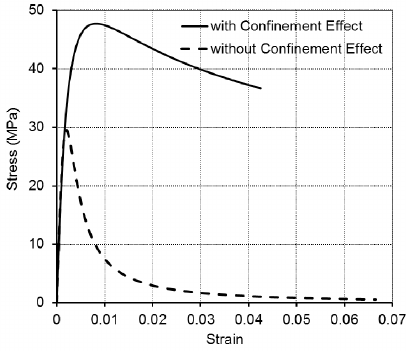
Figure 18. Concrete model for CoWiTA.